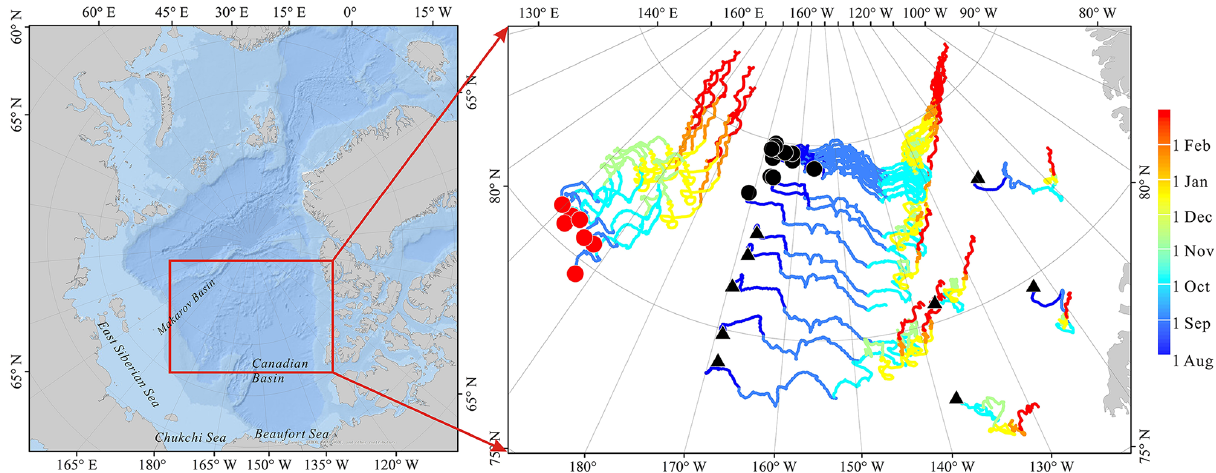
Figure 2. Buoy trajectories between deployment sites (indicated by circles and triangles) and buoy locations on 28 February 2019. Trajec- tories from 15 buoys deployed during CHINARE at locations indicated by black circles and 7 buoys deployed during TICE at locations indicated by red circles were used to estimate ice deformation rate. For buoys deployed prior to August 2018, the starting point of the trajectory was set to 1 August